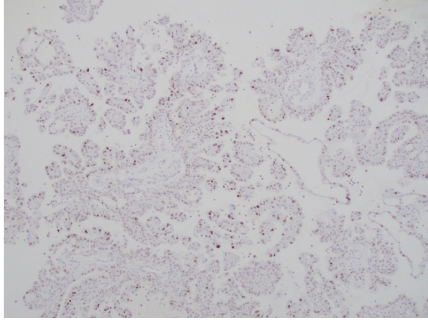
Figure 6: Diffuse nuclear positivity to p53 immunostain.